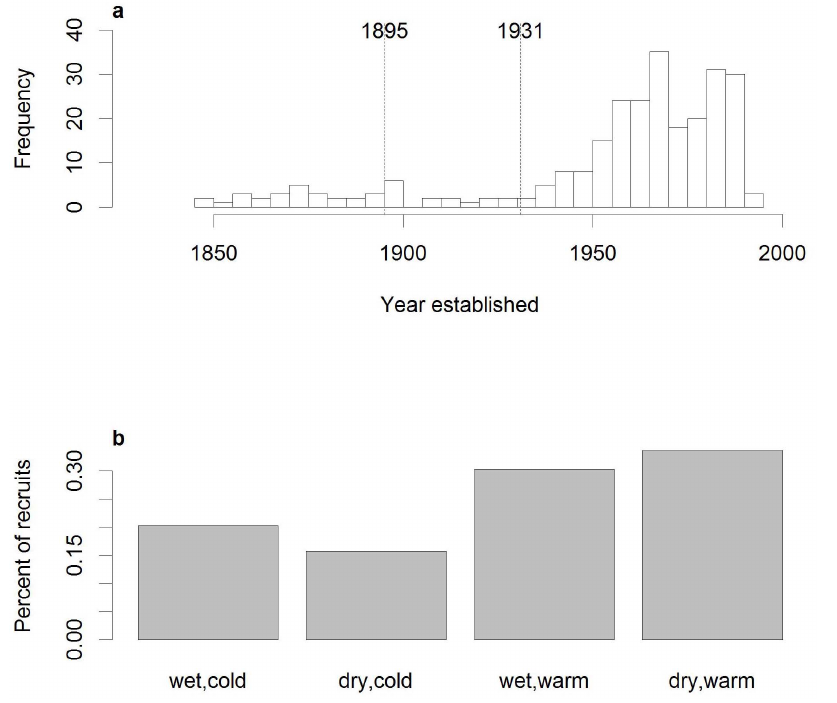
Figure 4. Age-class structure across all plots according to a) establishment year and b) climatic conditions. A) Frequency distributions of the year of establishment (in 5 year bins) for Dracophyllum plants across all plots. Dashed vertical lines represent the period in which farming occurred on the island. Livestock number and distribution were limited after 1931 but were not eradicated until 1991. This figure is modified from Bestic et al. [5]. B) The percent of total establishment across all plots in four winter climate categories between 1941 and 1993 according to winter precipitation and maximum temperature. Winter climate at the year of establishment is classed as whether winters were wet ( . 400 mm total precipitation) or dry ( , 400 mm total precipitation) and warm ( . 7 u C on average) or cool ( , 7 u C on